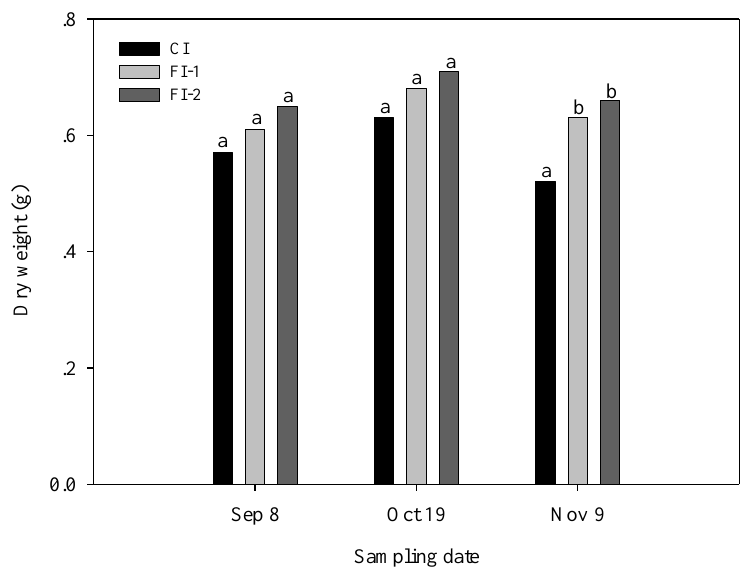
FIGURE 4. Comparisons of dry weight of roots among different treatments at different sampling dates. Different letters at the top of the bars indicate significant difference ( p <